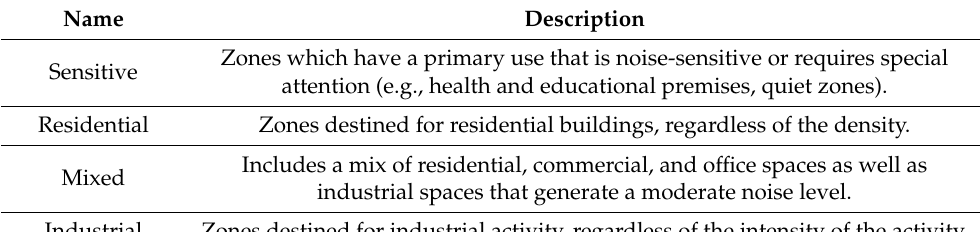
Table 2. Four categories of zones used to map noise